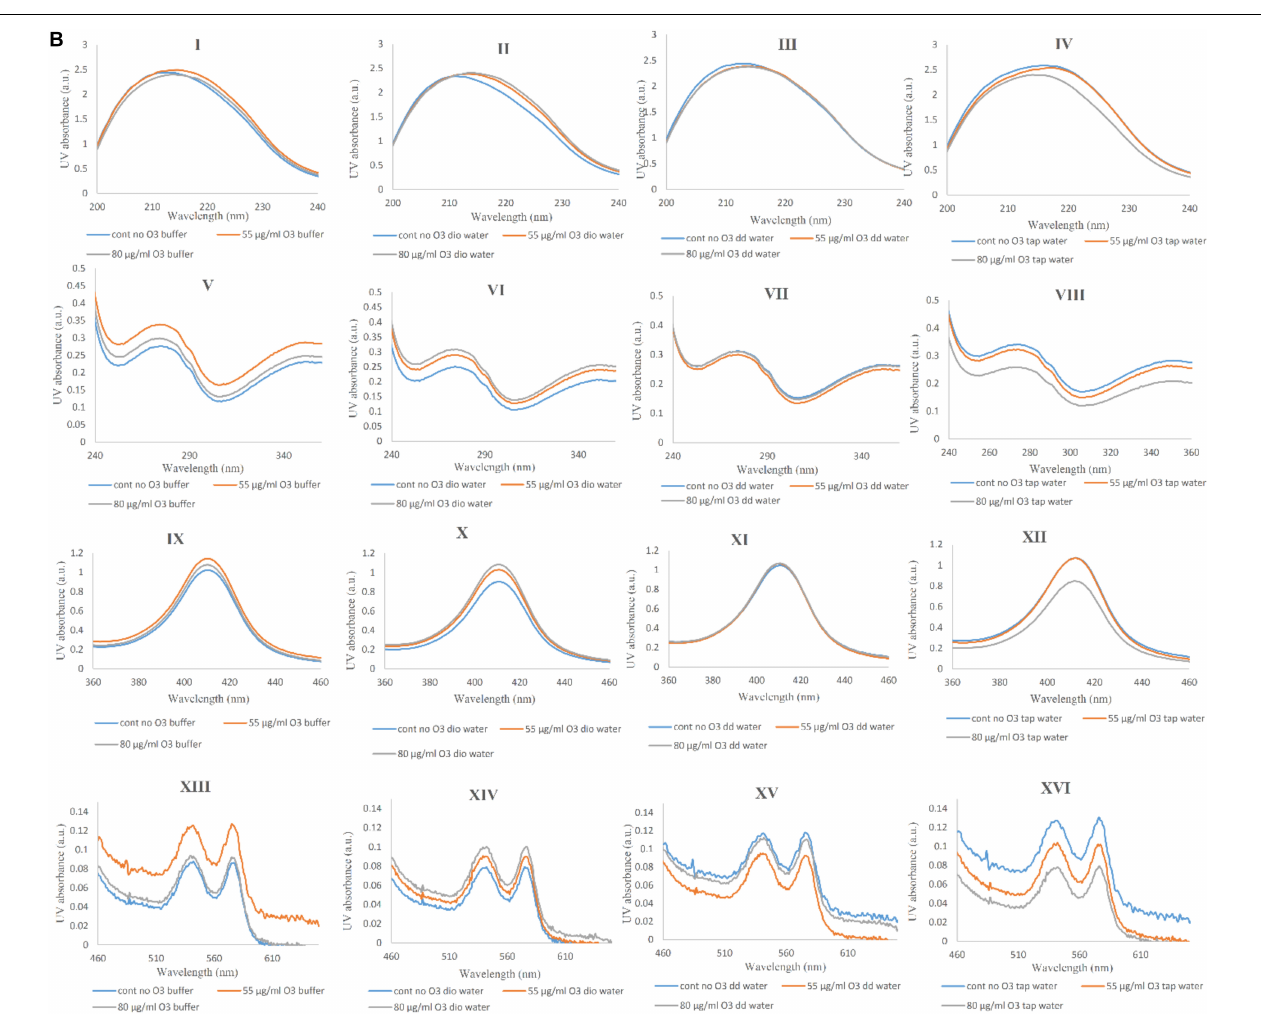
FIGURE 6 | UV-Vis spectra of non-ozonated and ozonated Hb samples in the presence of phosphate buffer and diluted versions with different water types. (A) UV-Vis spectra comparing Hb in phosphate buffer with different water types in the presence and absence of two different concentrations of ozone. (I, II, III) Non-ozonated, Hb ozonated at 55 and 80 µ g/ml in phosphate buffer and different water types, respectively (wavelength range 200–240 nm). (IV, V, VI) Non-ozonated, Hb ozonated at 55 and 80 µ g/ml in phosphate buffer and different water types, respectively (wavelength range 240–360 nm). (VII, VIII, IX) Non-ozonated, Hb ozonated at 55 and 80 µ g/ml in phosphate buffer and different water types, respectively (wavelength range 360–460 nm). (X, XI, XII) Non-ozonated, Hb ozonated at 55 and 80 µ g/ml in phosphate buffer and different water types, respectively (wavelength range 460–660 nm). (B) UV-Vis spectra comparing the effects of two different ozone concentrations on Hb in the different solvents including phosphate buffer and the diluted versions of it with different water types. (I, II, III, IV) Non-ozonated, Hb ozonated at 55 and 80 µ g/ml ozone in phosphate buffer, Dio water, DD water and tap water, receptively (wavelength range 200–240 nm). (V, VI, VII, VIII) Non-ozonated, Hb ozonated at 55 and 80 µ g/ml ozone in phosphate buffer, deionized (Dio) water, double distilled (DD) water and tap water, respectively (wavelength range 240–360 nm). (IX, X, XI, XII) Non-ozonated, Hb ozonated at 55 and 80 µ g/ml ozone in phosphate buffer, Dio water, DD water and tap water, receptively (wavelength range 360–460 nm). (XIII, XIV, XV, XVI) Non-ozonated, Hb ozonated at 55 and 80 µ g/ml ozone in phosphate buffer, Dio water, DD water and tap water, respectively (wavelength range 460–660 nm). In both panels (A) and (B) , the first, second, third, and fourth rows indicate changes in peptide bonds, aromatic residues, B-band and Q-bands,